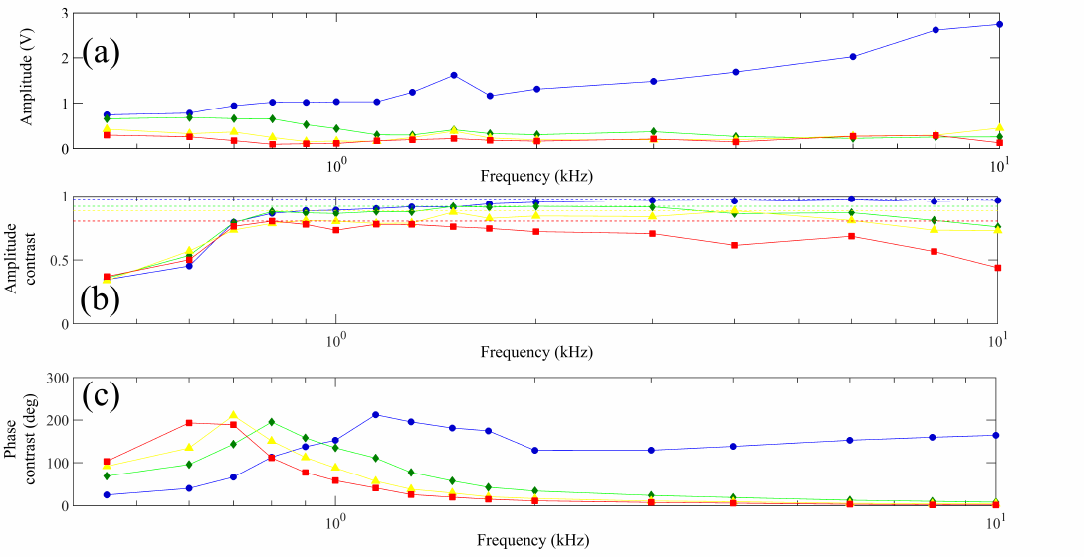
Figure 3. The change in amplitude ( a – c ) recorded scanning over an edge of the aluminum plate as a function of the rf primary frequency. The dependence is recorded with the edge covered by zero (blue dots), one (green diamonds), two (yellow triangles) and three (red squares) 0.5mm-thick aluminium